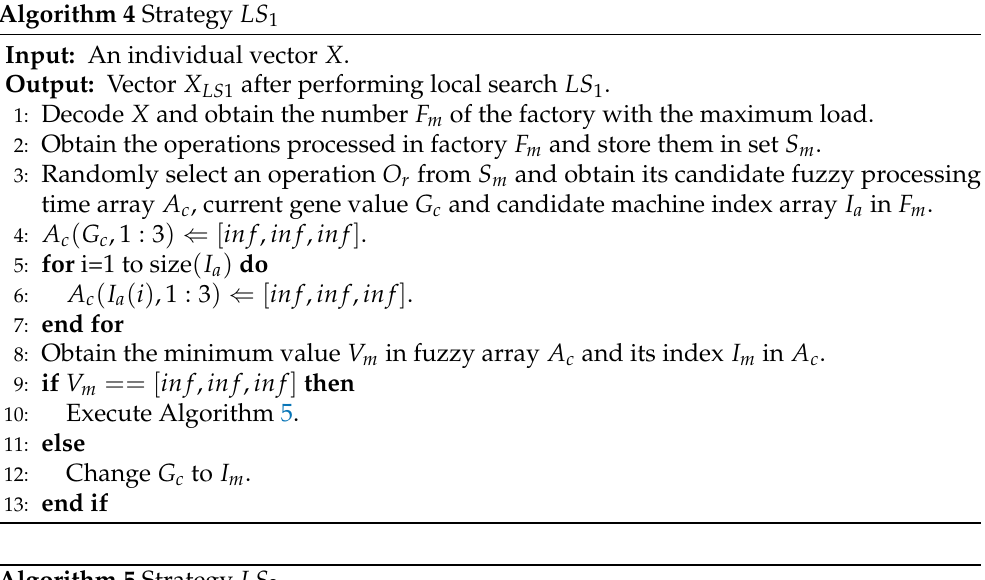
Algorithm 4 Strategy LS 1